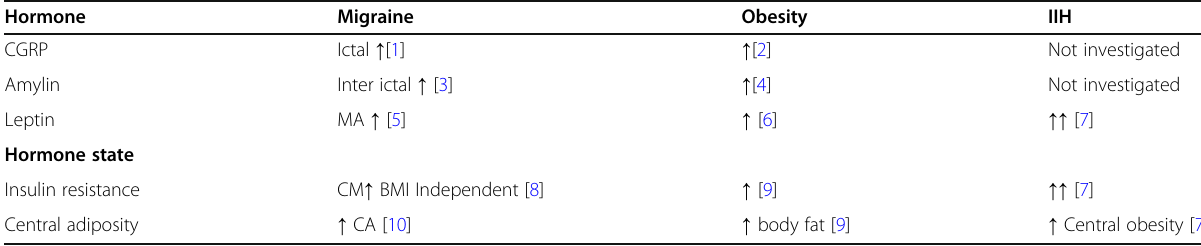
Table 2 Hormonal and anthropomorphic comparisons between obesity, migraine and IIH. Migraine with aura = MA, chronic migraine = CM, cutaneous allodynia = CA Hormone